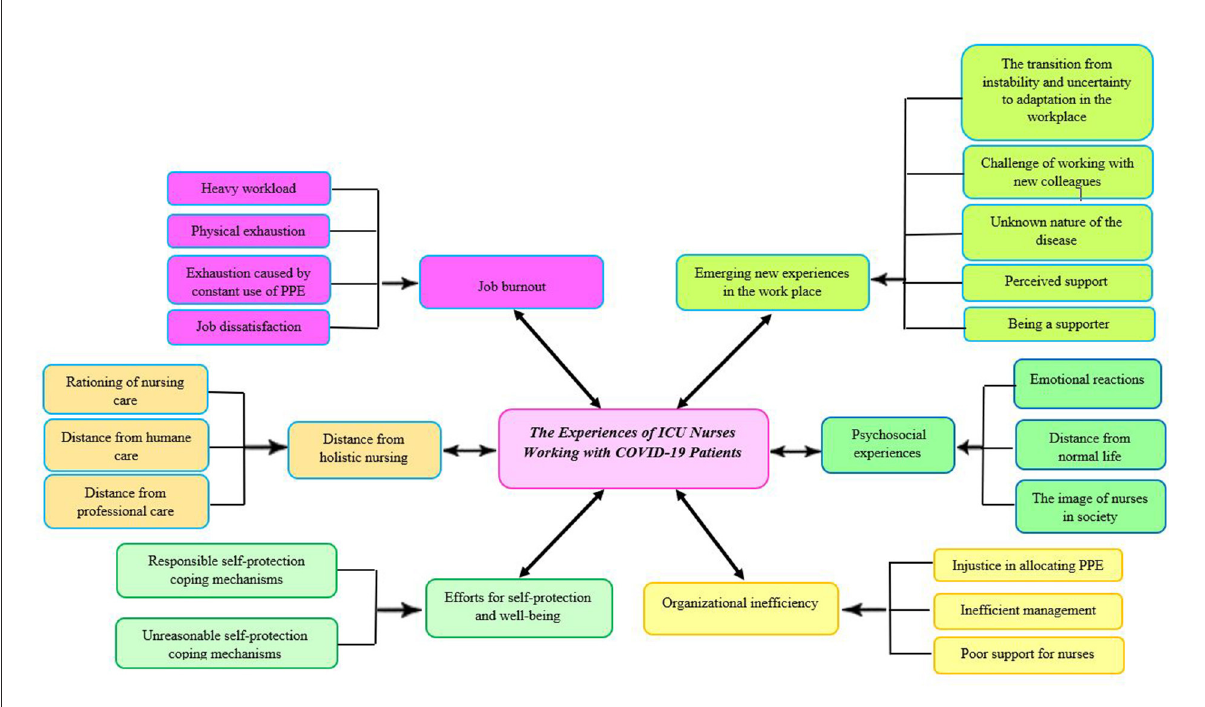
FIGURE2 Experiences of intensive care unit nurses working with COVID-19 patients.